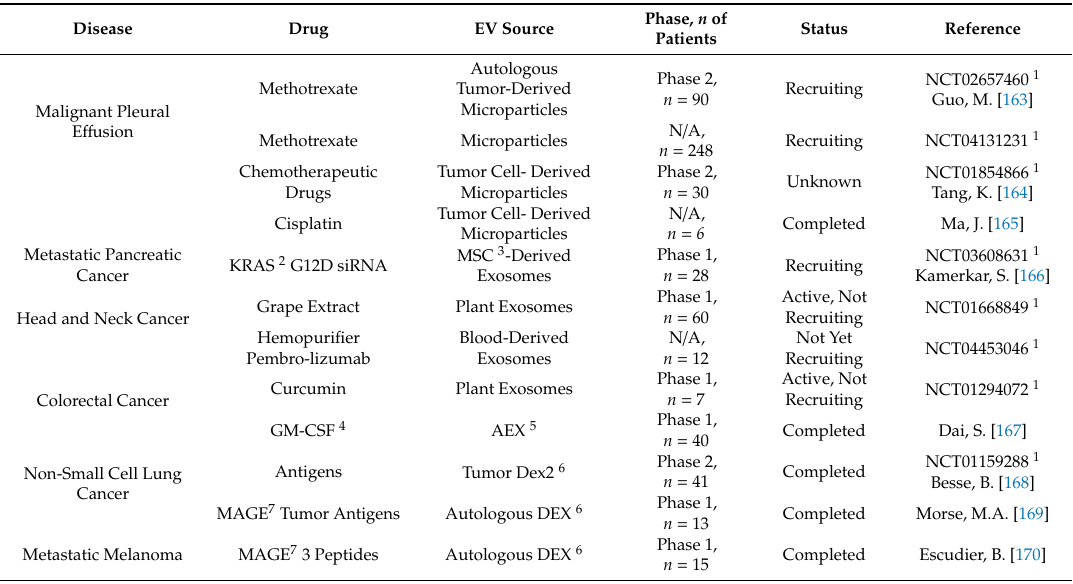
Table 1. Clinical trials of EV-based cancer